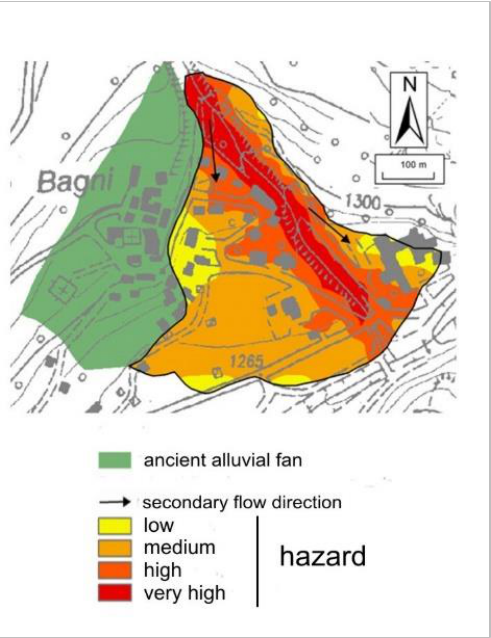
Figure 14. A detail of the hazard zoning map of the alluvial fan on which the Bagni di Vinadio inhabited area has grown.